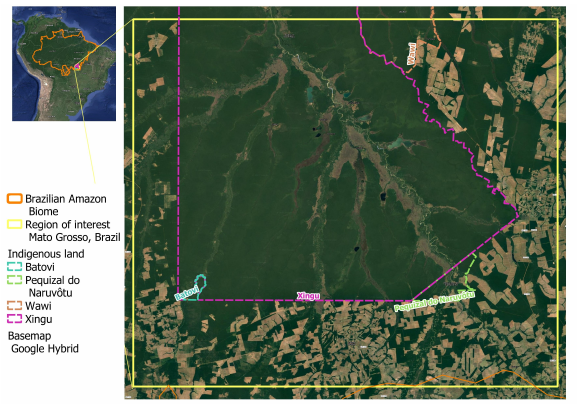
Figure 2: Selected region of interest